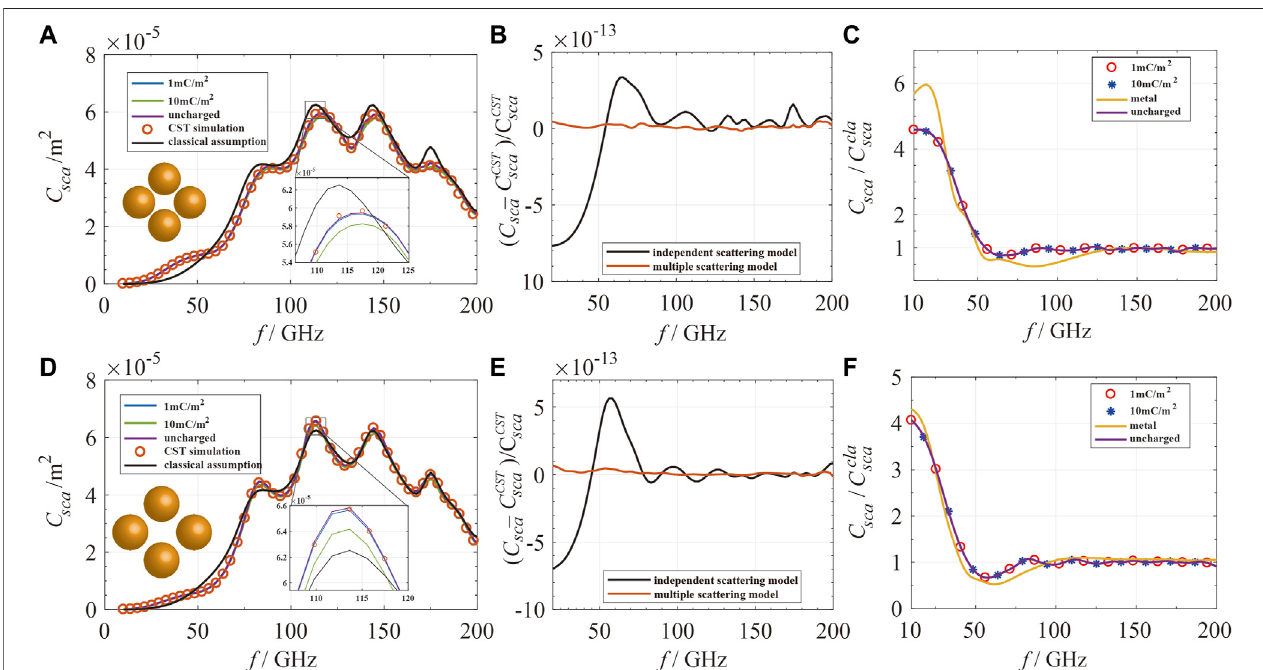
FIGURE6| Thescatteringcrosssectionsforfour-particleclusterswithdifferentseparationsandchargedensities.Firstcolumn:thescatteringcrosssectionoffour- particle clusters calculated under the multiple scattering method (for uncharged particles and charged particles), classical independent scattering assumption, and CST simulation (for uncharged particles) with radius of the particles equal to 1 mm, R equals (A) 1.5 mm and (D) 2 mm. Second column: the relative difference between the result calculated under classical assumption, multiple scattering model, and CST simulation for R equal to (A) 1.5 mm and (D) 2 mm. Third column: the ratio of scatteringcross section calculated under themultiple scatteringmethod tothe resultscalculated withthe classical assumptionfor R equal to (A) 1.5 mm and (D) 2 mm.